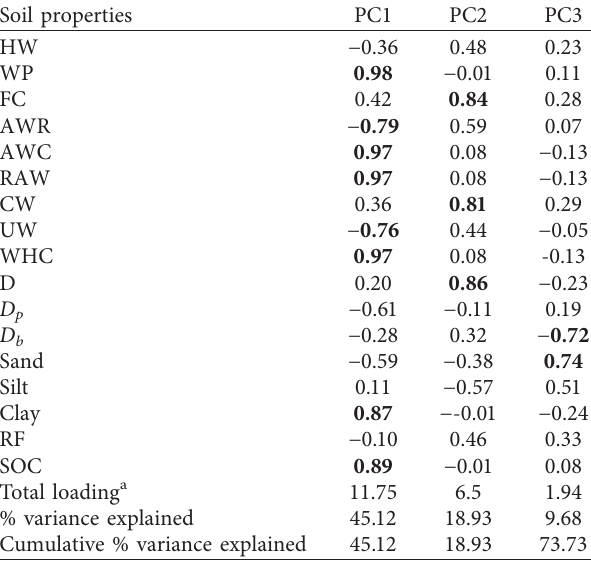
Table 7: Principal component analysis generated based on factor loading ( n � 20).